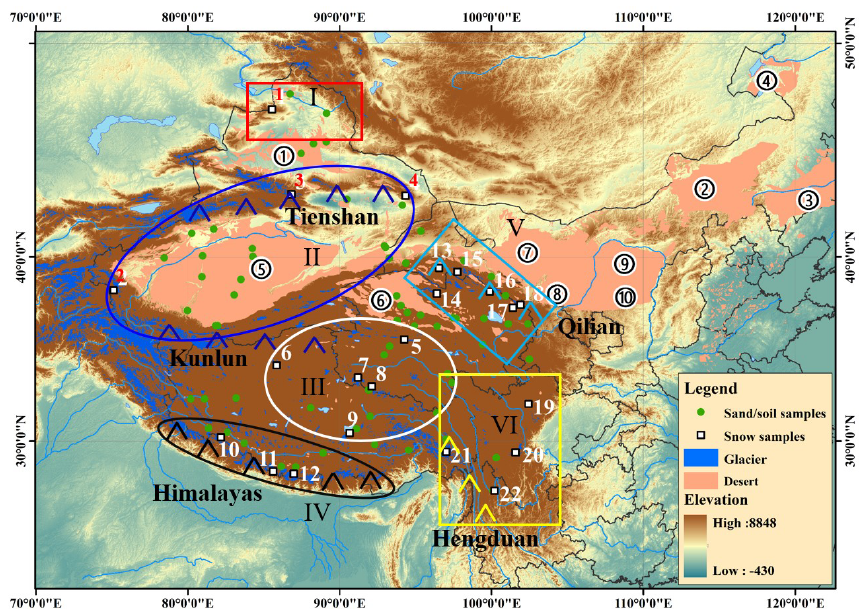
Figure 2. The glacier and desert distributions in western China. The different colored oval and rectangular shapes represent the six subregions in the third pole: PSAs and glaciers, the Tienshan Mountains, the Kunlun Mountains, the Qilian Mountains, the Himalaya Mountains, and the Hengduan Mountains. Numbers and white squares represent 22 glaciers (snow samples were collected from these glaciers), the names of which are shown in Table 2. The numbered circles represent the 10 desert or sandy areas in China: 1. Gurbantünggüt Desert, 2. Onqin Daga sandy land, 3. Horqin sandy land, 4. Hunlun Buir sandy land, 5. Taklimakan Desert, 6. Qaidam Desert, 7. Badain Jaran Desert, 8. Tengger Desert, 9. Hobq Desert, and 10. Mu Us Desert. The green solid circles represent sand and soil samples. (This figure was created with